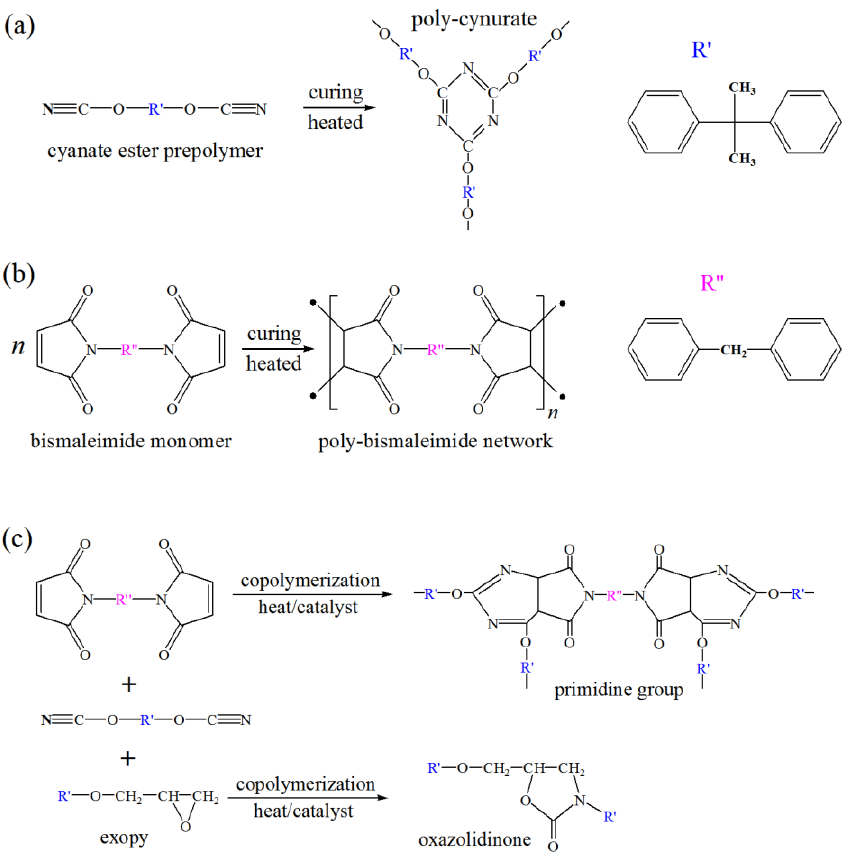
Figure 1. Schematic polymerization of the blended CE, BMI and EP monomers. ( a ) CE self-polymerization; ( b ) BMI self-polymerization; ( c ) copolymerization of CE with BMI and EP.